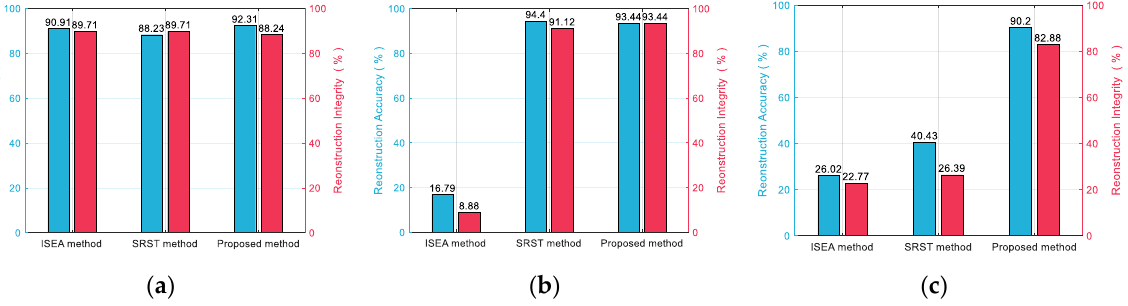
Figure 9. The reconstruction accuracies and integrities of different methods on ( a ) HST, ( b ) Aqua, and ( c ) Tiangong-1.